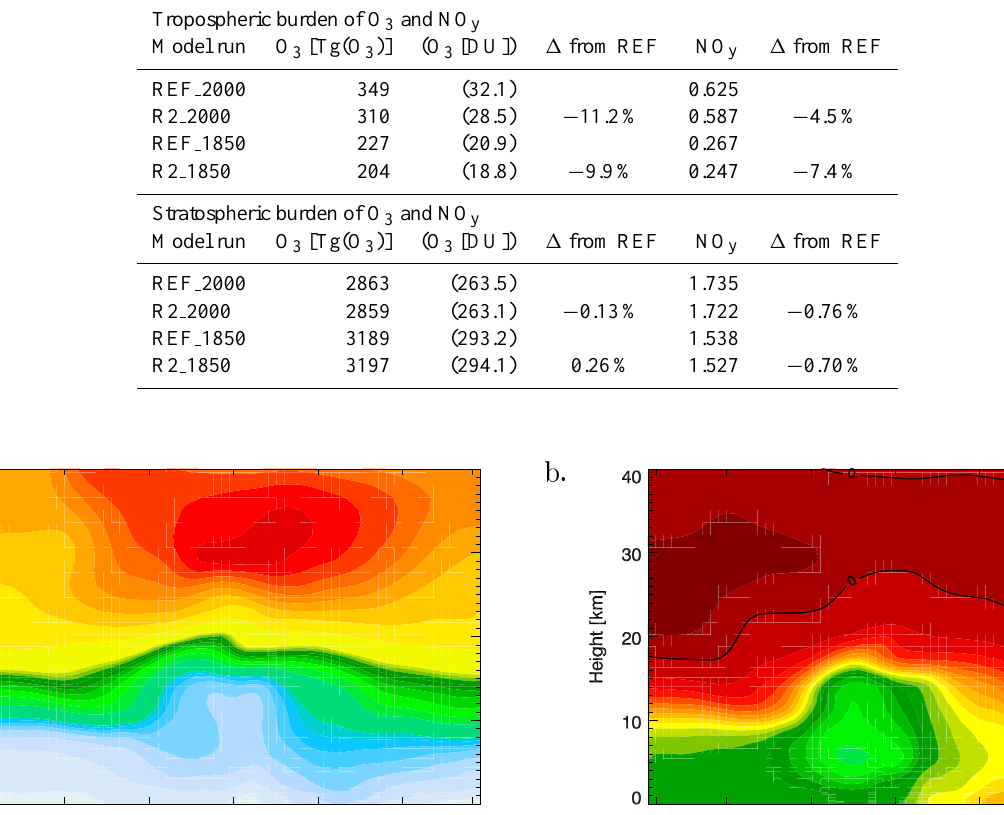
Table 4. Annual tropospheric and stratospheric budgets of O 3 and NO y . Units for O 3 are Tg(O 3 ) and Dobson Units (DU) in parenthesis, while NO y is given as Tg(N). Note that these burdens are calculated using the model tropopause (as defined in the Sect. 3.5), while RF calculations use a slightly different tropopause (Sect. 5). As an example, the R2 tropospheric burden in RF calculations changes by 12 . 3DU from 1850 to 2000, while the stratospheric burden changes by − 33 . 3DU.